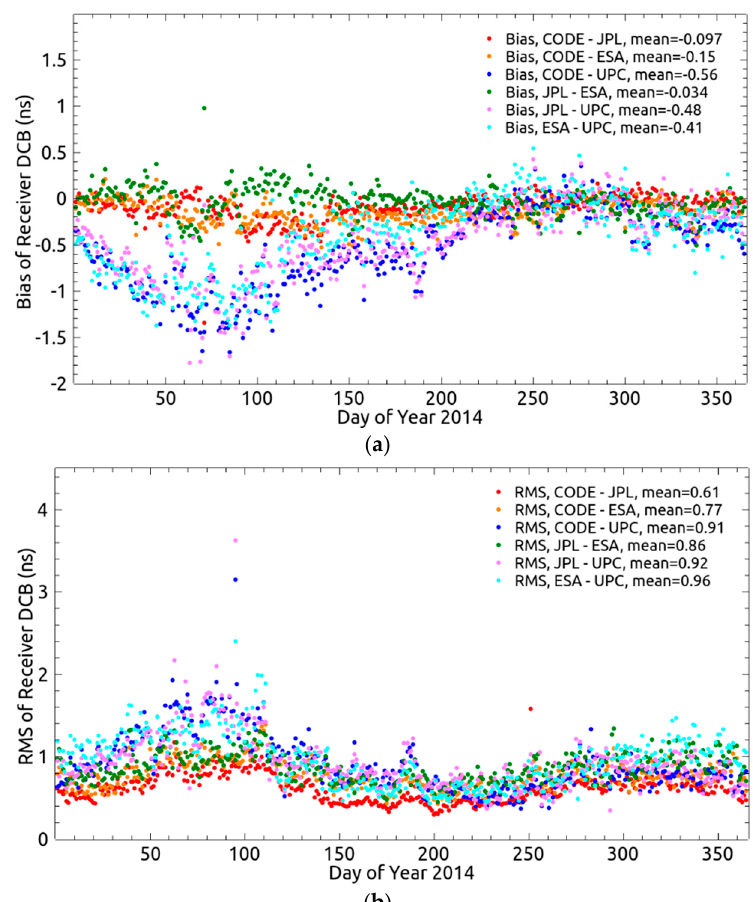
Figure 4. Differences in receiver DCBs among IAAC products in 2014. ( a ) Biases of receivers DCB comparisons among IAAC products. ( b ) RMS of differences in receivers DCB among IAAC products.